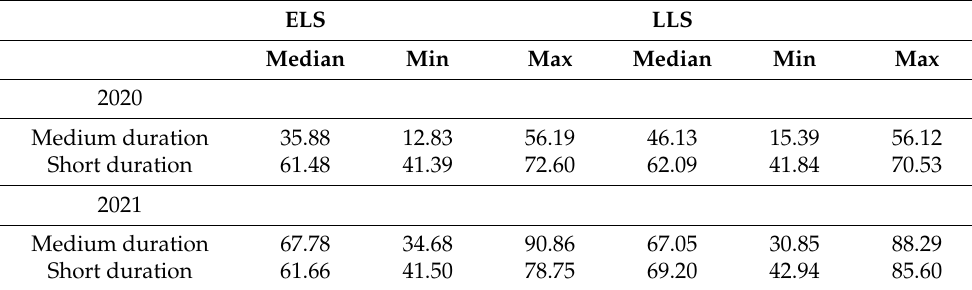
Table 3. Summary of AUDPC scores among the studied groundnut genotype. ELS LLS Median Min Max Median Min